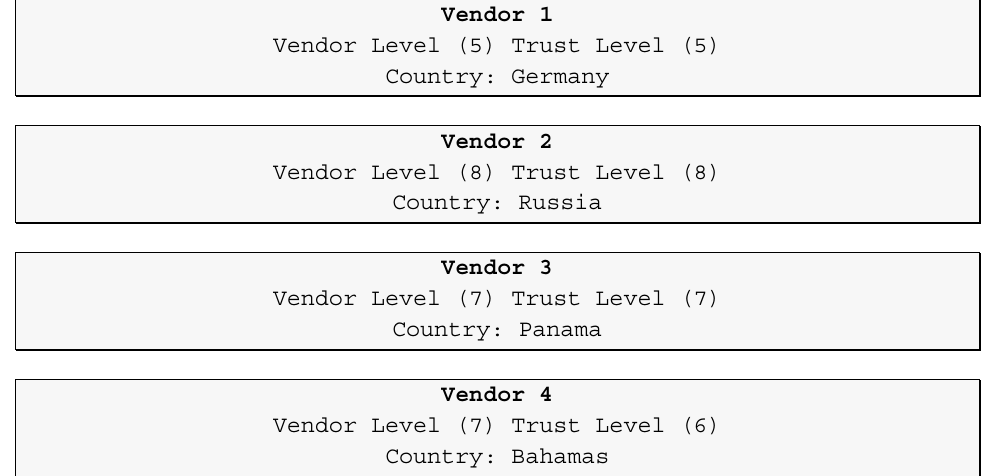
Figure 8. Marketplace Vendors Positively Identified (Names Redacted).